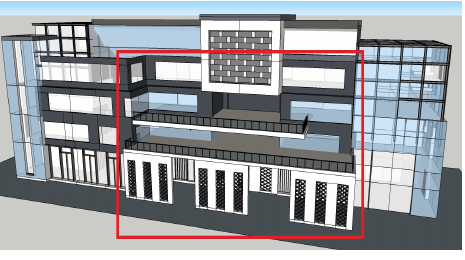
Figure 8. A 3D building model.